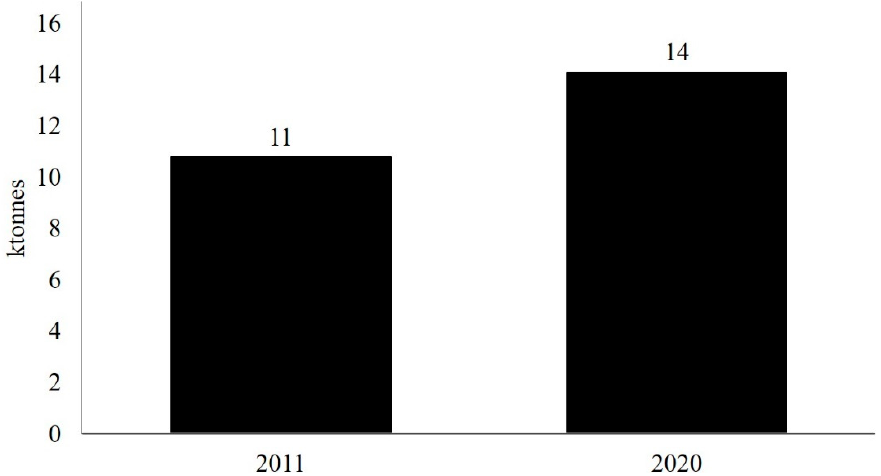
Figure 2. Estimation of non-hazardous agricultural and livestock production in Greece.